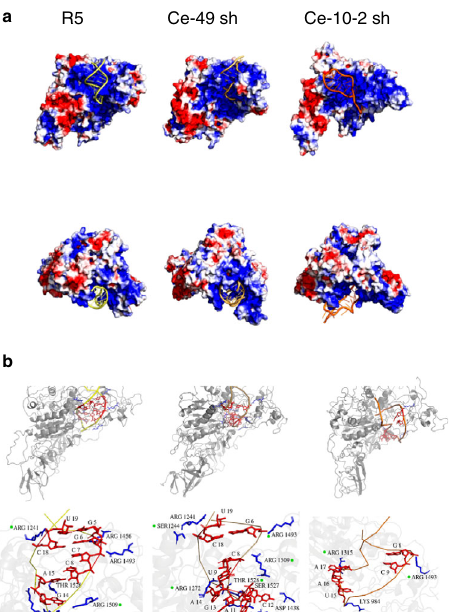
Fig. 7 | Molecular dynamic analyses. a Molecular dynamic representative struc- tures of R5 or Ce-49 sh and Ce-10-2 sh aptamer-DNMT1 complex simulations, in explicit waters for 300 nanoseconds (ns), derived using a RMSD-based clustering approach as described in the method section. DNMT1 protein is shown in surface and coloured according to the electrostatic potential. The red colour (negative potential) arises from an excess of negative charges near the surface and the blue colour(positivepotential)occurswhenthesurfaceispositivelycharged (±3kT/e). The white regions correspond to fairly neutralpotentials. Foraptamerregions, the following colour scheme was adopted: R5:yellow, Ce-49 sh: brown and Ce-10-2 sh: orange. b MoleculardynamicrepresentativestructuresofR5ofCe-49shandCe-10- 2 sh aptamer-DNMT1 complexes derived using a RMSD-based clustering approach among the overall frames of all the last 150ns of the three replica runs. DNMT1 protein is shown in transparent cartoon and coloured in grey. For aptamers, the following colour scheme was adopted: R5:yellow, Ce-49 sh: brown and Ce-10-2 sh: orange. The top panels show a global view of the complexes. The bottom panels show a zoom of the anchor points between the protein (in blue sticks) and the aptamers(inredsticks),presentedatleast20%amongtheconcatenatedtrajectory of OL15 run simulations. The green dots indicate protein residues shown to be involved in persistent hydrogen bonds also during the simulation with the Parmbmsc1 force fi